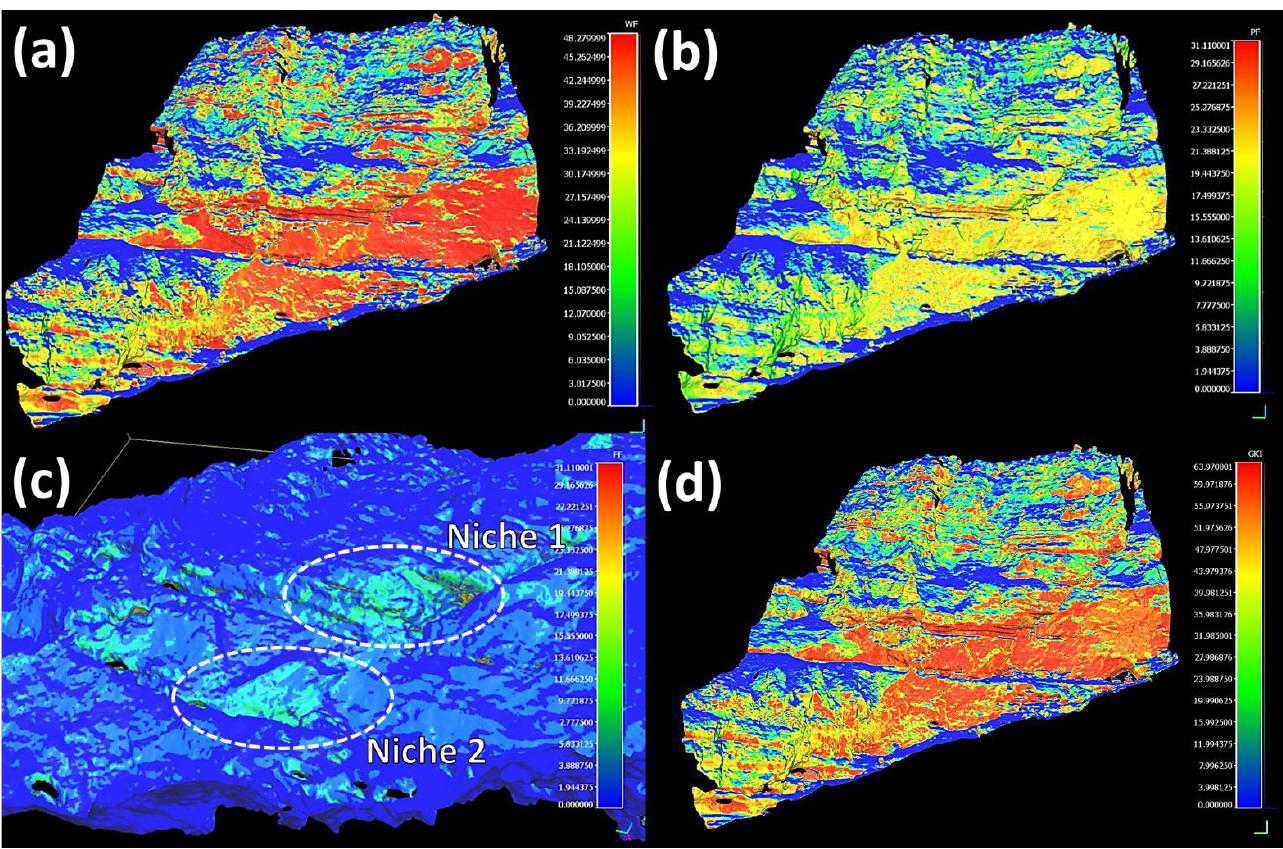
Figure 9. Results of the 3D kinematic analysis. Wedge failure = 48% ( a ); planar failure = 31% ( b ); free fall = 31% (white ovals highlighting the detected unstable niches) ( c ); GKI up to 62% ( d ).